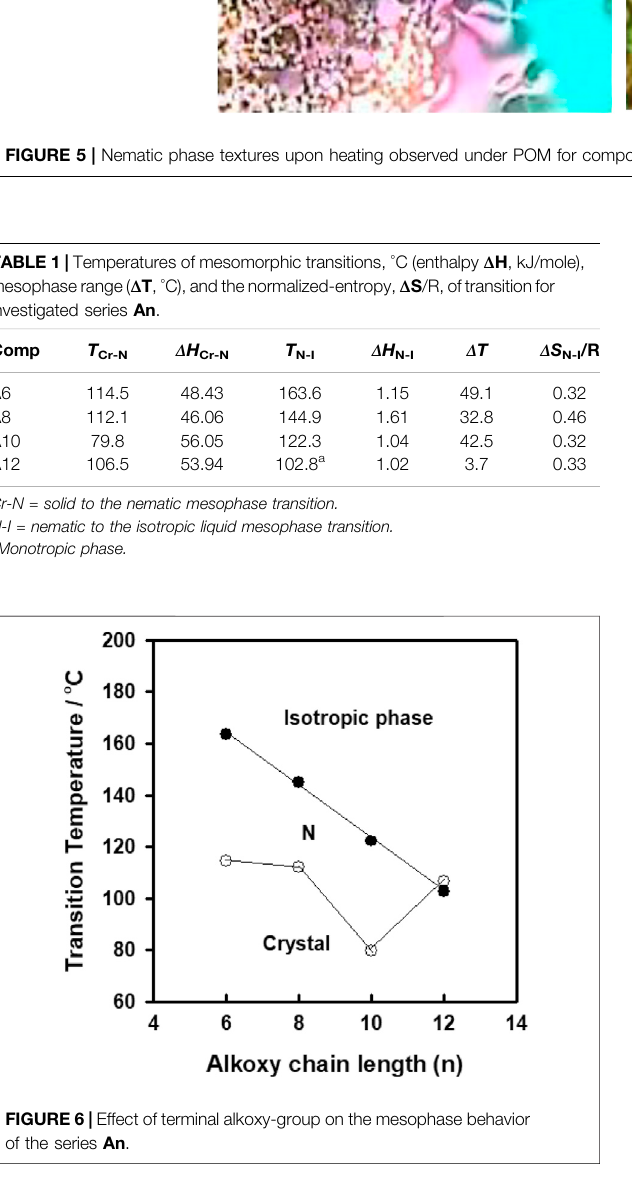
Frontiers in Chemistry |